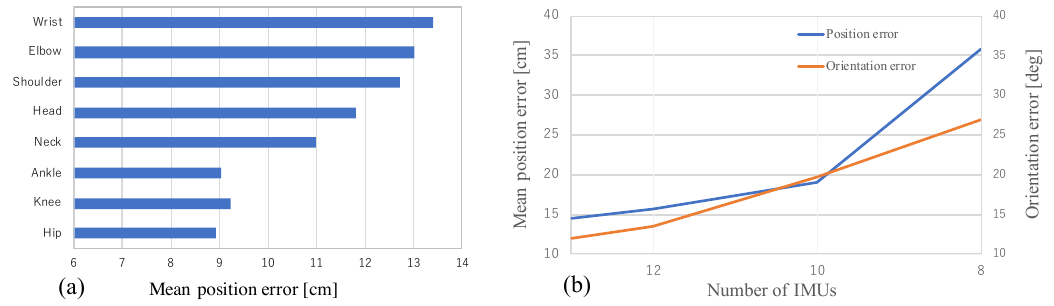
Figure 4. ( a ) Mean per-joint positional error of the human motion capture (MoCap) by the proposed method on all the scenes in the test set. The error values of wrist, elbow, shoulder, ankle, knee, and hip represent the average error of the both side of the segments, i.e., the error of the wrist denotes the average error of left wrist and right wrist. ( b ) Mean 3D position and orientation errors on subjects S3-F1 and S4-F3 with 8 to 13 IMUs.